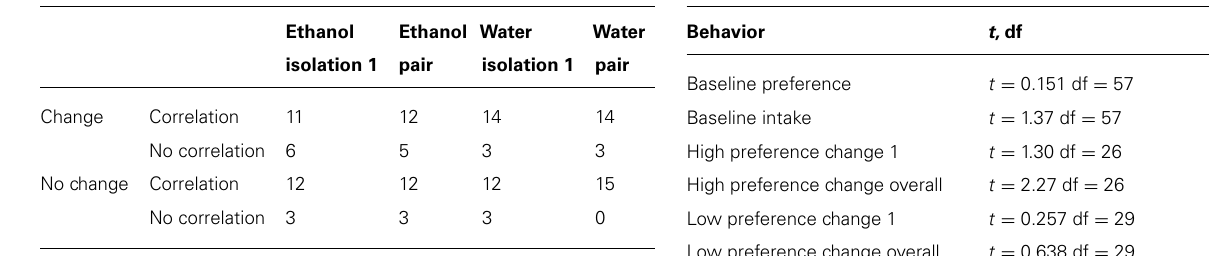
Table 2 | Effect ofV1aR microsatellite length on ethanol drinking